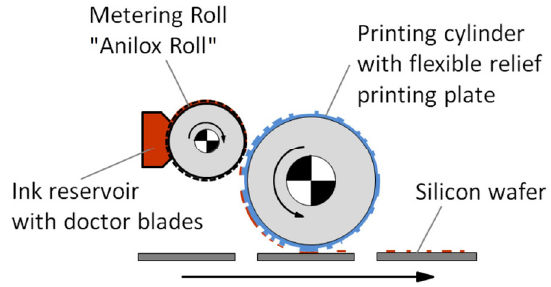
Figure 1. Schematic of a flexographic printing platform for the metallization of silicon solar cells. Ref. [28] Copyright 2015 .